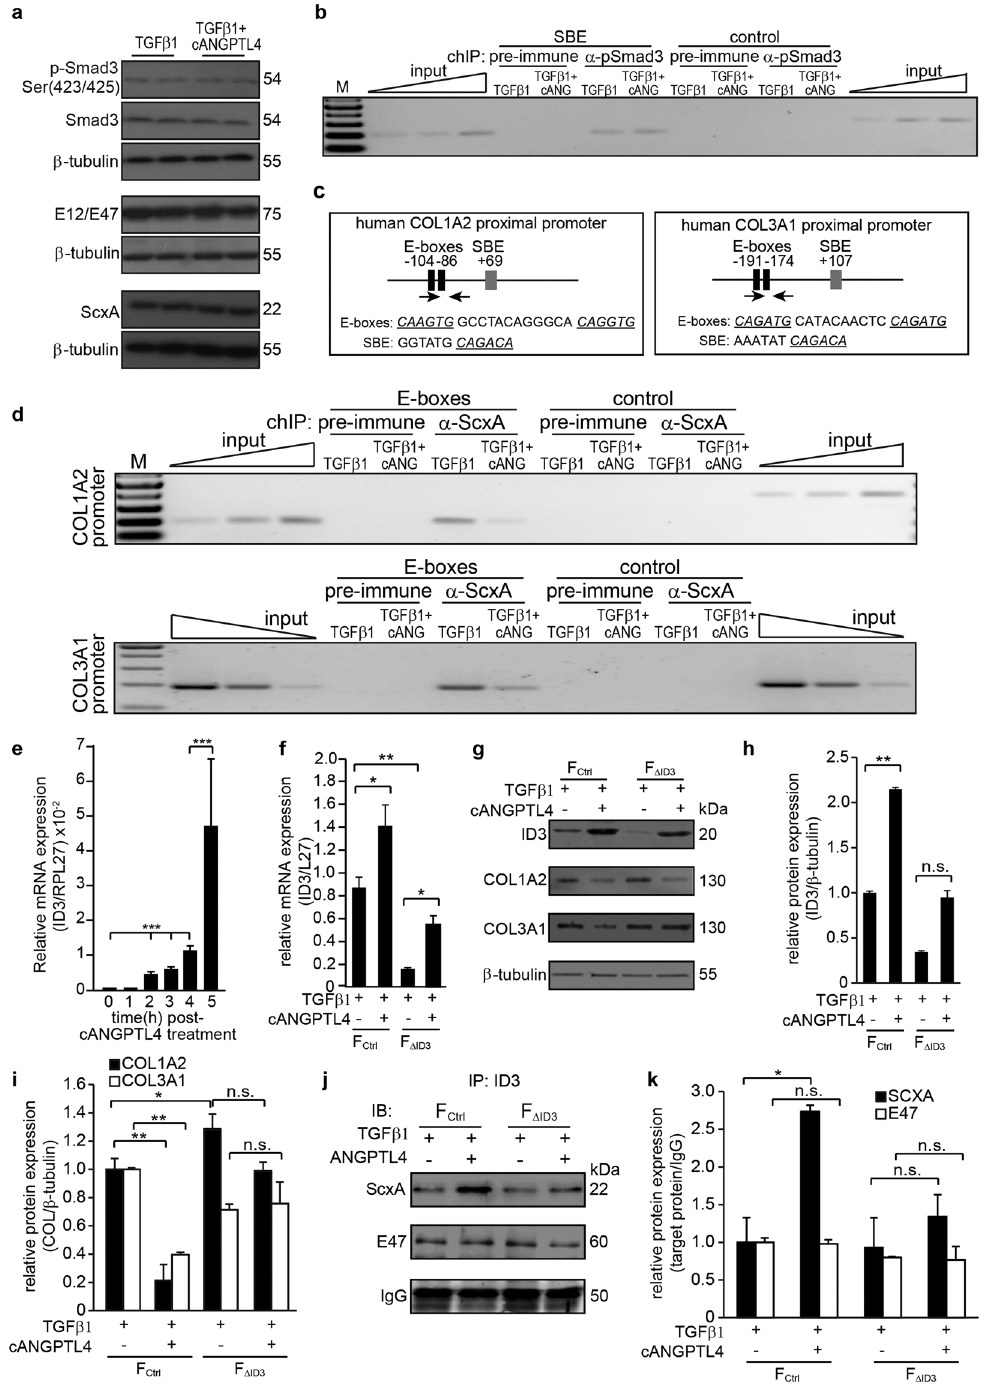
Figure 3. cANGPTL4 regulates COL1A2 and COL3A1 expression in fibroblasts via a bHLH-dependent signaling mechanism. ( a ) Immunoblot analysis of indicated proteins from fibroblasts treated with cANGPTL4 (12 µ g/mL) in the presence or absence of TGF β 1 (10 ng/mL). β -tubulin, as loading control, was from the same samples. ( b,d ) Chromatin immunoprecipitation (ChIP) of SBE sites in the human COL1A2 gene promoter region and E-box sites in the human COL1A2 and COL3A1 gene promoter regions using phospho-Smad3 antibodies and scleraxis (ScxA) antibodies respectively. The gene sequences spanning the SBE and E-box sites and a random control sequence were analyzed by PCR from immunoprecipitated chromatin from fibroblasts treated with TGF β 1 in the presence or absence of cANGPTL4 (cANG). Pre-immune serum was used as a control. PCR was performed using chromatin before immunoprecipitation as input. M, 100 bp DNA ladder. ( c ) A schematic diagram showing the relative positions of Enhancer boxes (E-Boxes) and Smad binding elements (SBE) on the human COL1A2 and COL3A1 proximal promoters. Sequences of E-Boxes and SBE are shown. ChIP PCR primers designed specifically to bind scleraxis along this proximal promoter region